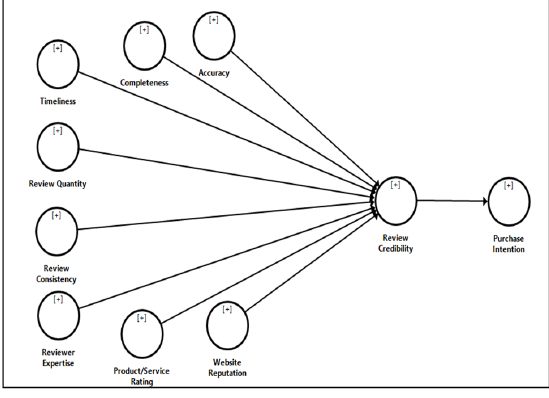
Fig. 1. Conceptual Research Model